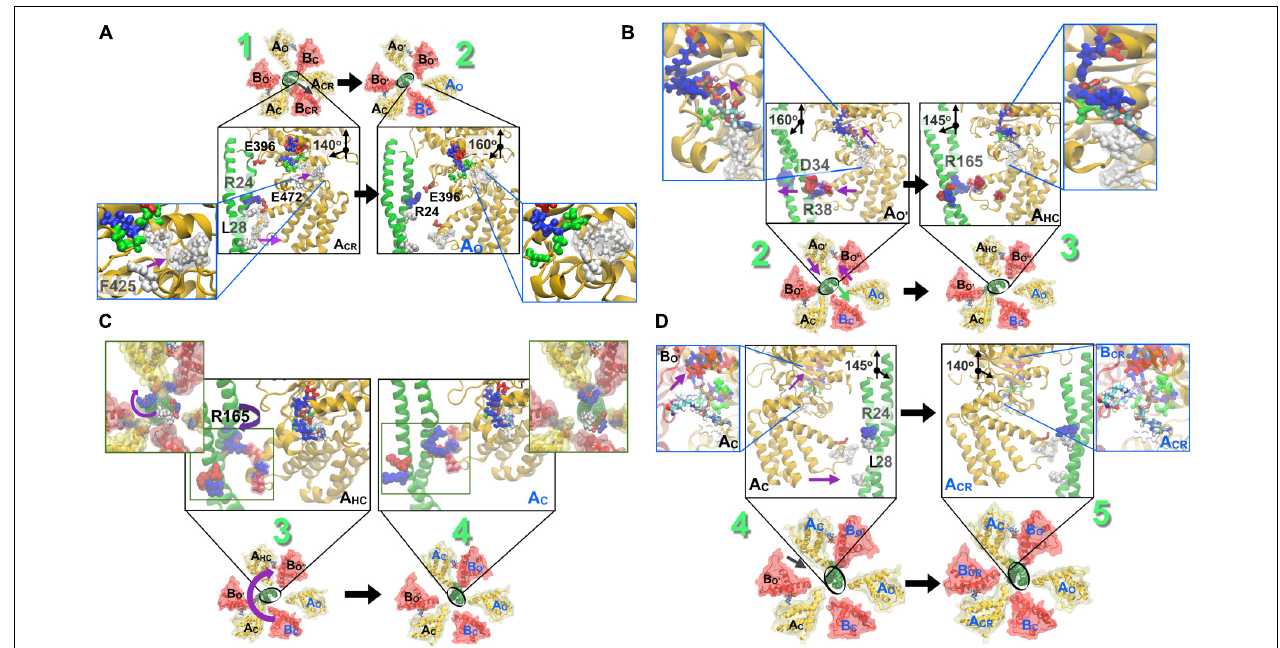
FIGURE 7 | Stepwise breakdown of the rotation mechanism captured in string simulations. (A) 1 → 2 transition . Outward swivel of the A subunit, by 20 ◦ , during the A CR → A O transition is allosterically coupled to the motion of F425 in the ATP binding pocket. L28 (also presented in Figure 6 ) becomes solvent exposed. (B) 2 → 3 transition. Inward swivel of the A subunit by 15 ◦ during the A O (cid:48) → A HC transition is allosterically coupled to the motion of F425 in the ATP binding pocket (inset). As ATP crawls into the ‘bindable’ site ( Figure 5 ), F425 forms a π – π stacking interaction with the adenine base, which is accompanied by an inward swiveling motion of the A O (cid:48) . (C) 3 → 4 transition. Rotation of the DF-shaft follows to reinstate the lost interactions of several residues. First, the R194 from the shaft binds to the E347 from A O following which E180 and R14 from the shaft combines with R271 of B O (cid:48) and E352 of A C and thereafter residues E161, R164 and R165 from the shaft reorganize to be stabilized by R475 of the A HC , E384 of B O (cid:48)(cid:48) and E472 of A H C , respectively. (D) 4 → 5 transition. Inward swivel of the A subunit, by 15 ◦ , during the A C → A CR reinstates the salt-bridge interactions between R24 from the shaft and E472 from A CR . As in Figure 6 , blue beads indicate basic residues, red indicates acidic, and white indicates hydrophobic ones. Figure adapted from components in Singharoy et al.